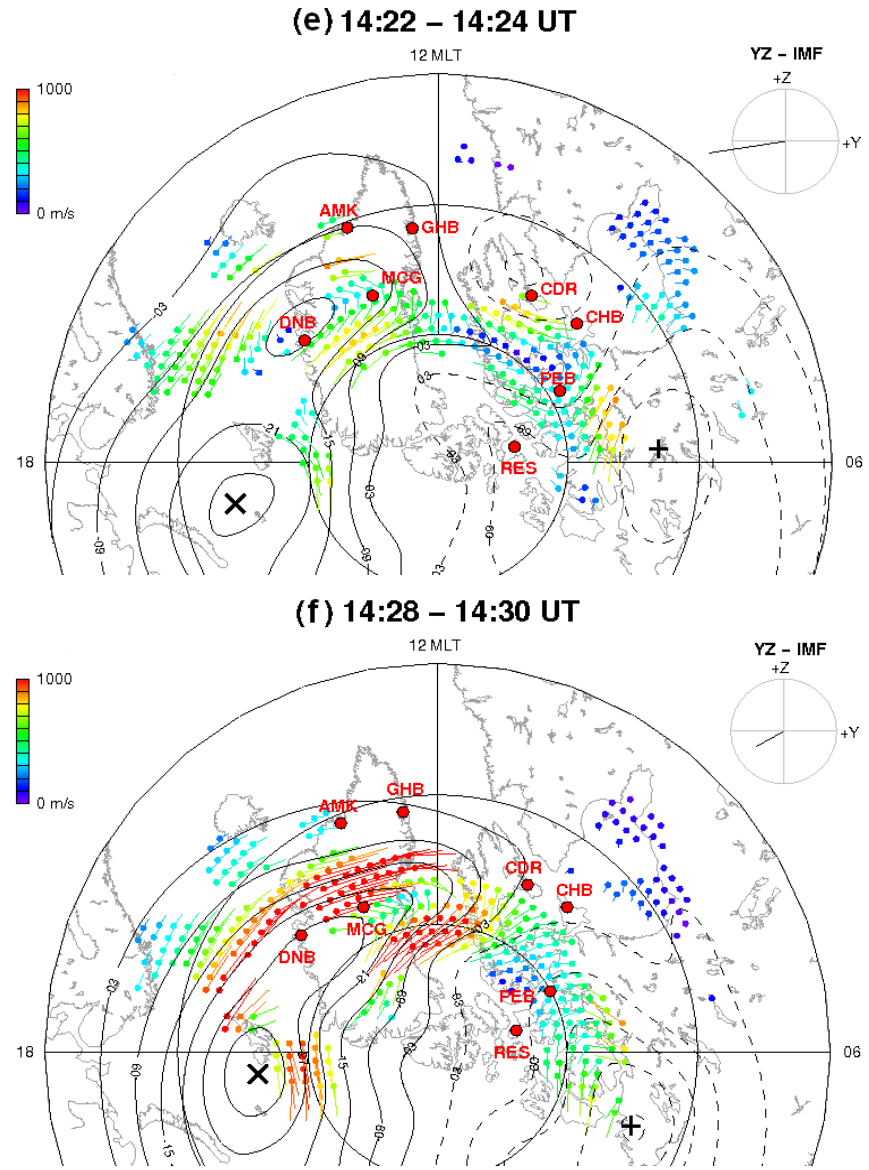
Fig. 6. Continued. Northern Hemisphere SuperDARN convection maps for 6 January 1998, between 14:22 and